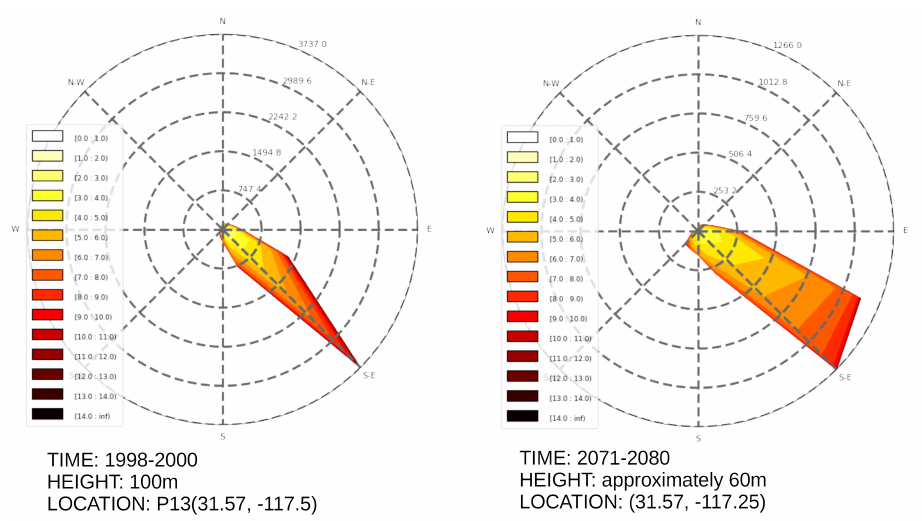
Figure 4. Comparison between the long-term wind roses for the P13 point at 100 m height ( left ) and in the proximity of the same point at approximately 60 m height ( right ) for the present and future time periods, respectively. Wind speed units are